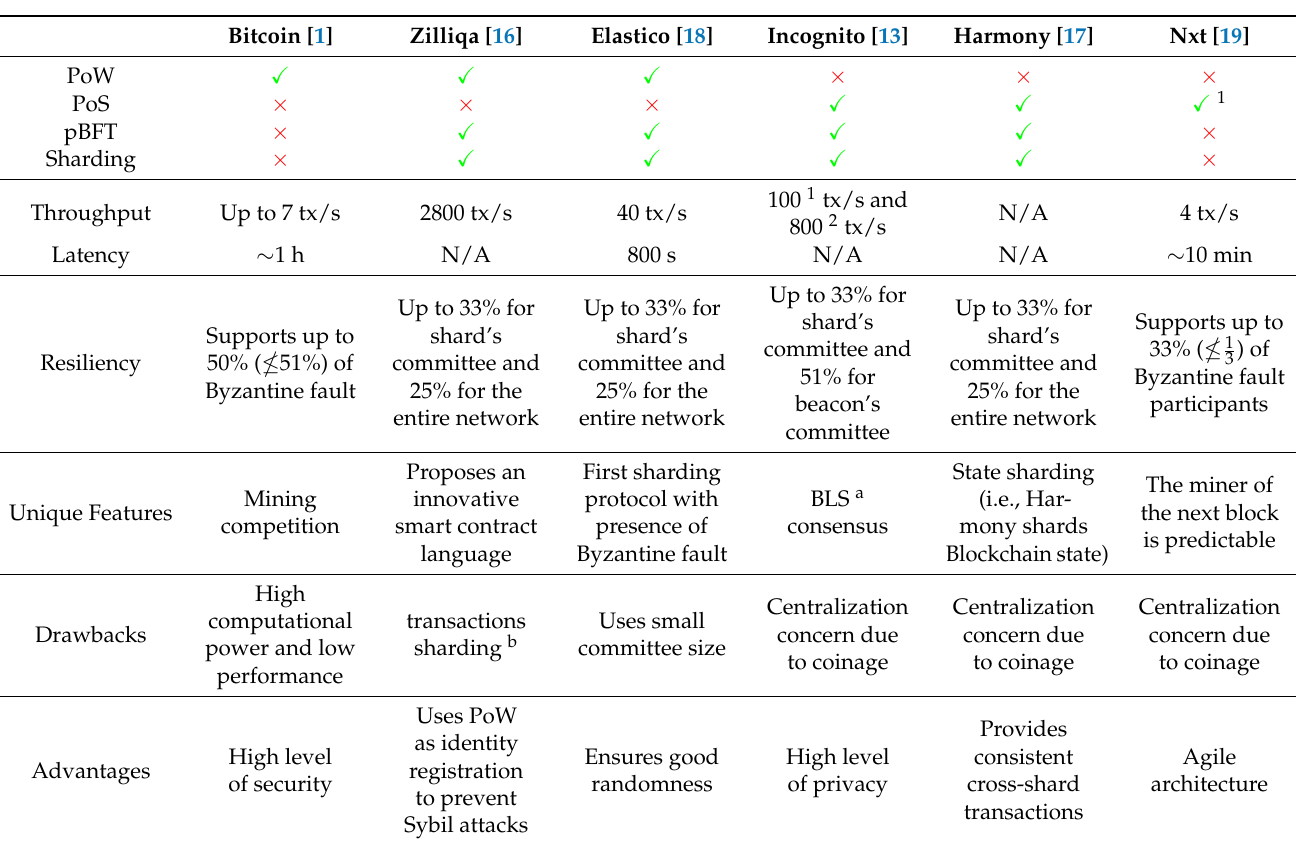
Table 1. Bitcoin vs. Sharding-Based PoW Blockchain Protocols vs. Sharding-Based PoS Blockchain